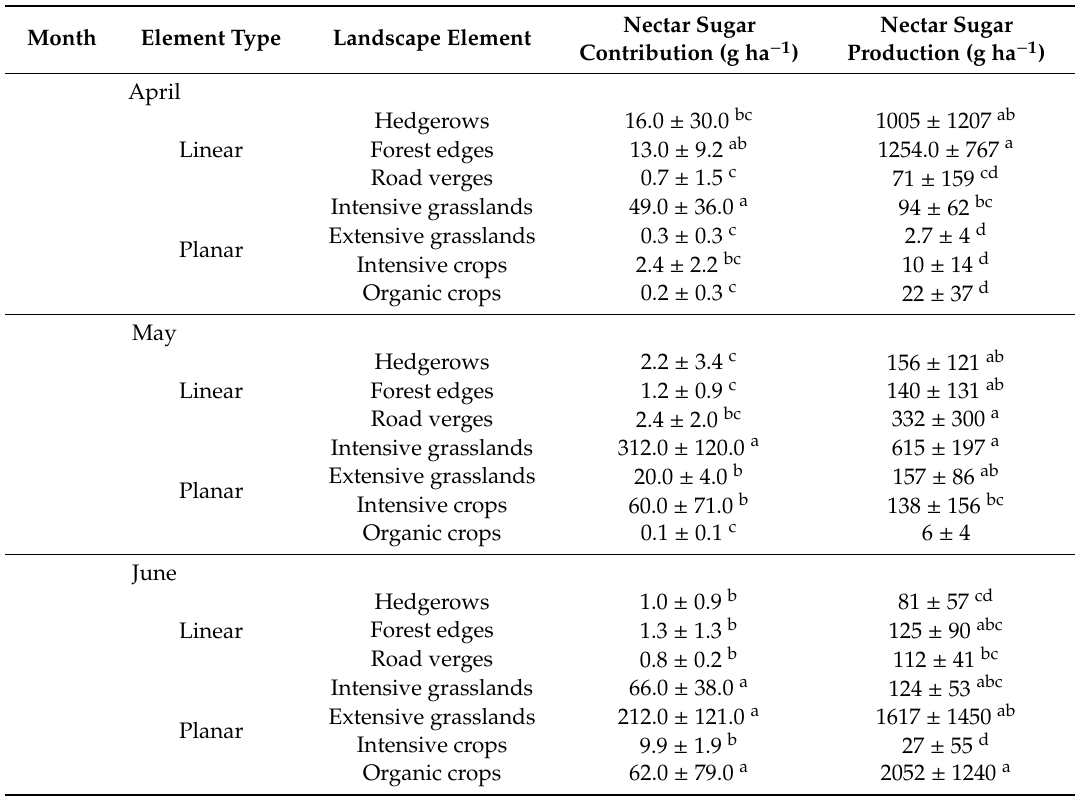
Table 2. Average daily nectar sugar contribution for each landscape element at the landscape scale in a typical 1 ha of the landscape (nectar sugar contribution), and daily nectar production in one hectare of the given landscape element (nectar sugar production). Di ff erent superscript letters indicate significant di ff erences among nectar